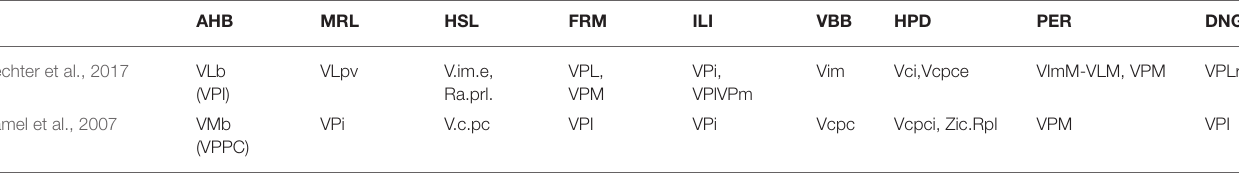
TABLE 2D | Anatomical characterization of the stimulation sites for tremor patients in the studies of Fiechter et al. (2017) and Hamel et al.